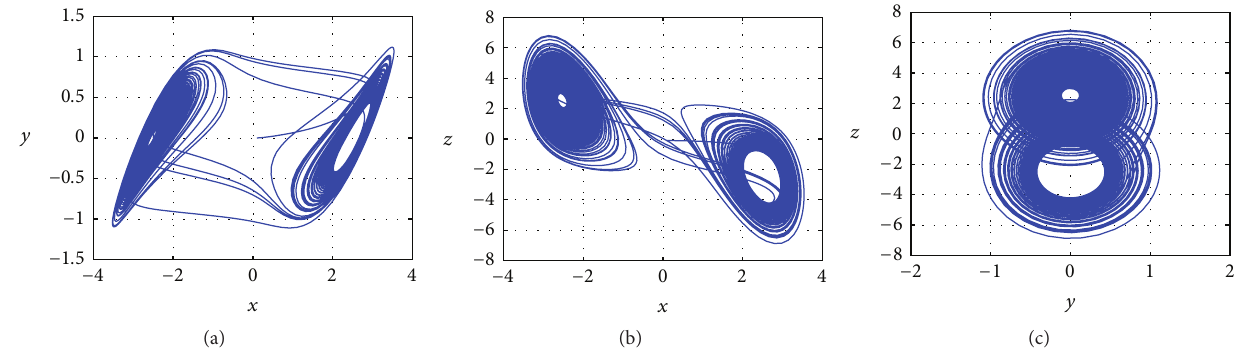
Figure 1: The phase portraits of Chua’s system